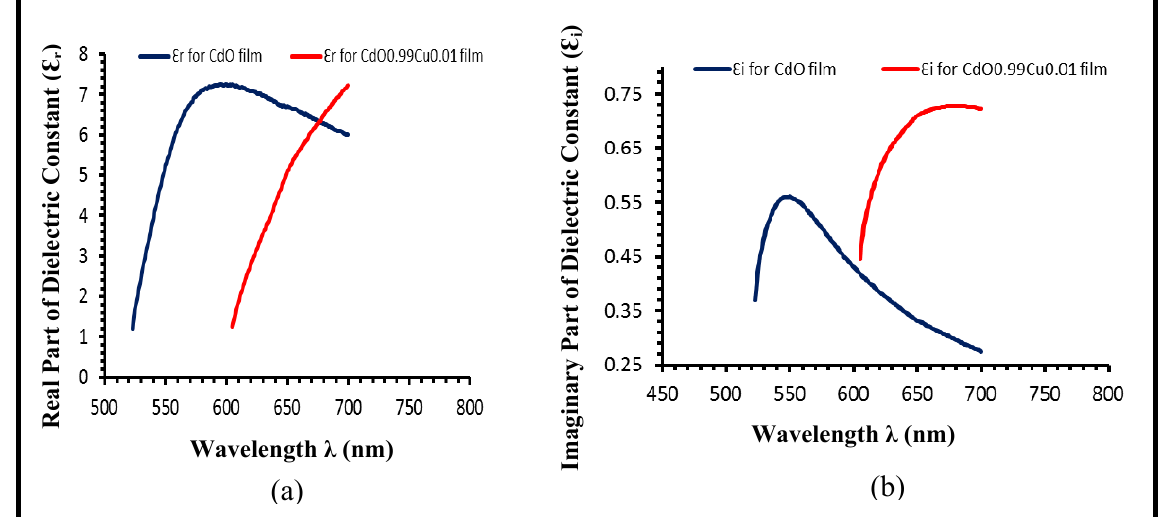
Fig. 10: Variation of dielectric constant parts (a) Real part (b) Imaginary part, for both CdO